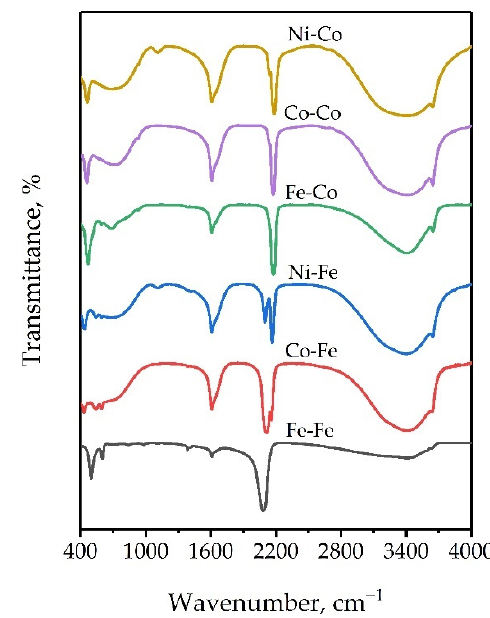
Figure 3. FT-IR spectra for the studied porous hexacyanometallates(III). Table 1. Frequency (in cm − 1 ) of FT-IR adsorption bands of studied porous hexacyanometallates(III).